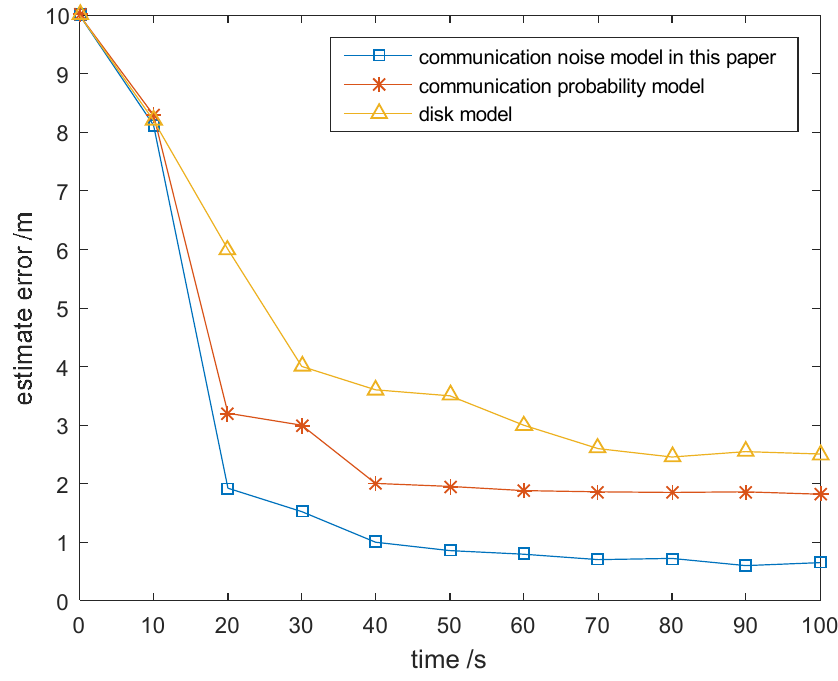
Figure 7. The average estimate error compared with other methods in fading environment.